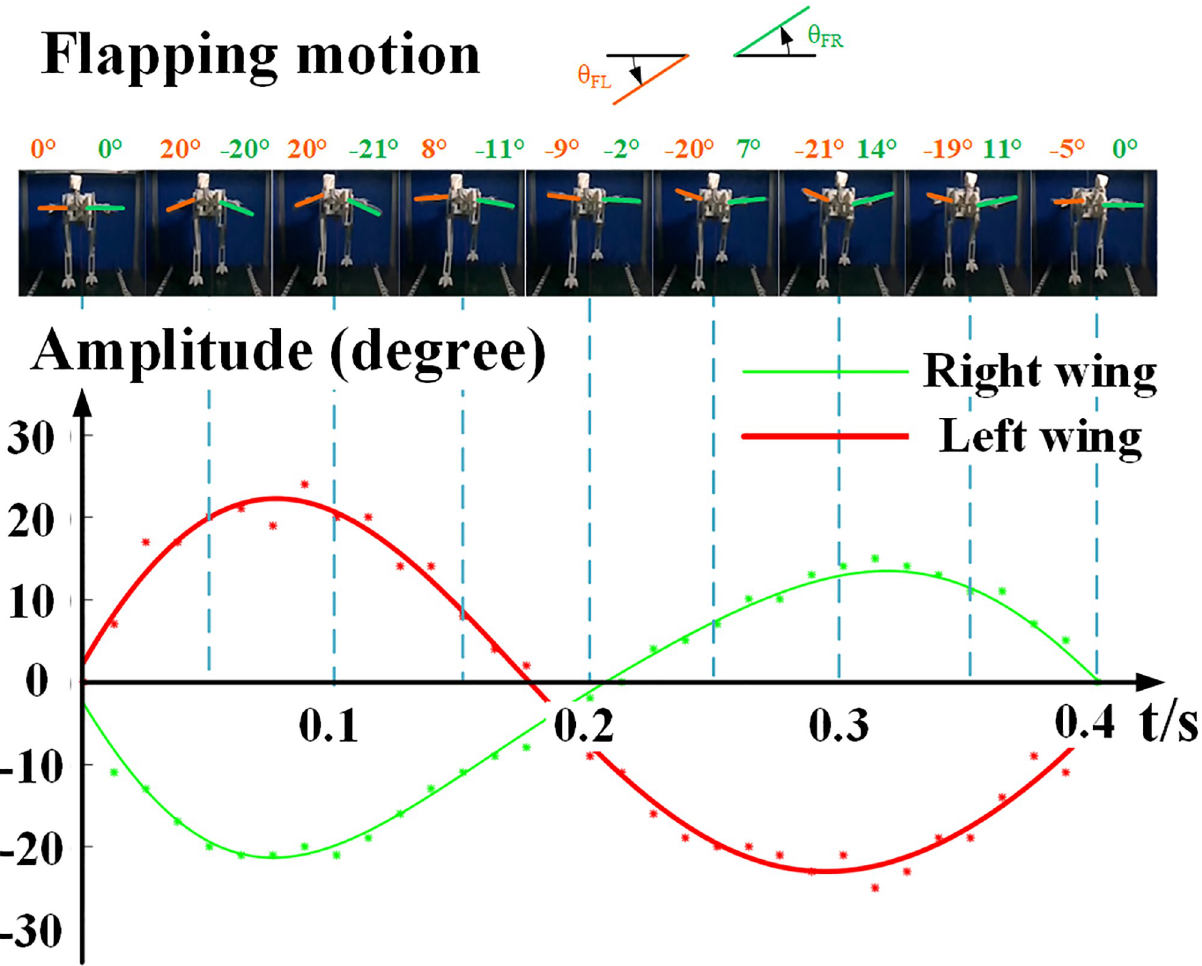
Fig 4. Forced vibrations of wings of Caudipteryx robot deduced by test rig (S1 Video) which approaches the flapping flight of modern birds [56]. Through curve iteration, we obtained the flapping function θ right = 932.7sin(19.01t − 3.35)+28.18sin(15.25t − 5.103)+898.2 sin(19.16t+6.034) and θ left = 135.6 sin(6.453t+1.808)+1558 sin(0.4013t+6.198)+6.517 sin(18.87t + 0.4756). We here defined the anticlockwise motion of both wings as the positive direction. Therefore, the down stroke for the left wing is a positive motion while the down stroke for the right wing is a negative one.